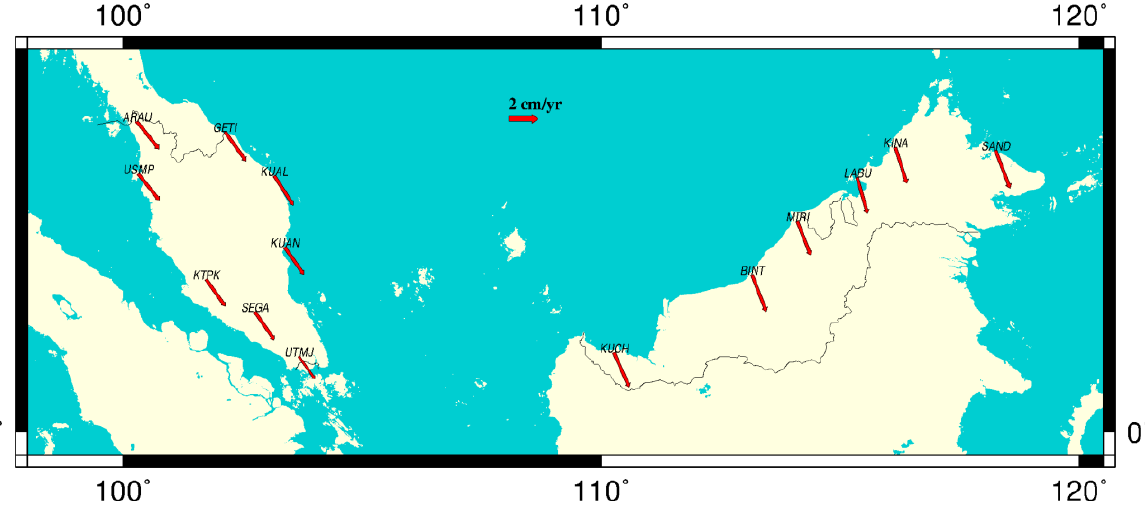
Figure 4. MASS velocity vector map for years 2001 to